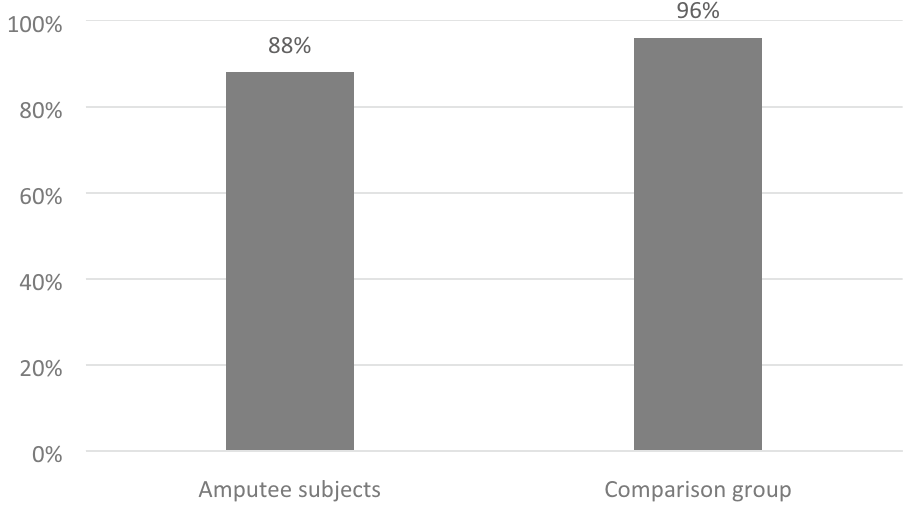
Figure 3. Participants with high self-esteem according to the Rosenberg Self-Esteem scale ( p = 0.609).